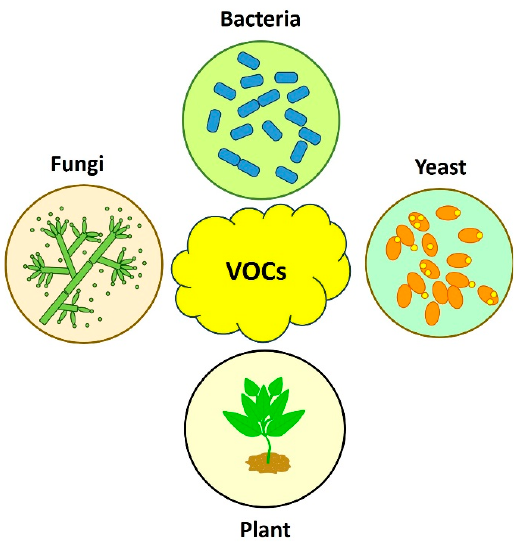
Figure 1. Organism producers of volatile organic compounds with biocontrol applications.